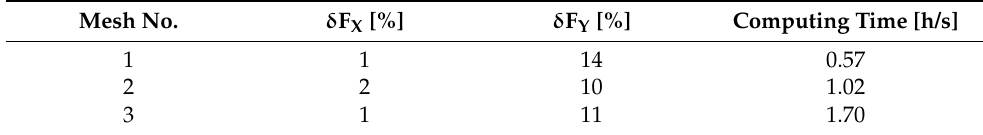
Table 7. Influence of mesh density on the accuracy of computations and computing time. Mesh